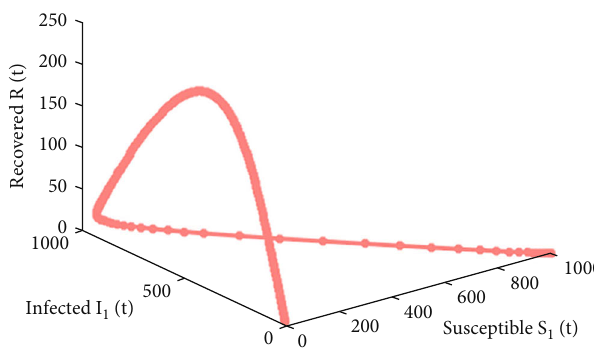
Figure 28: Variation of di ff erent individuals when R